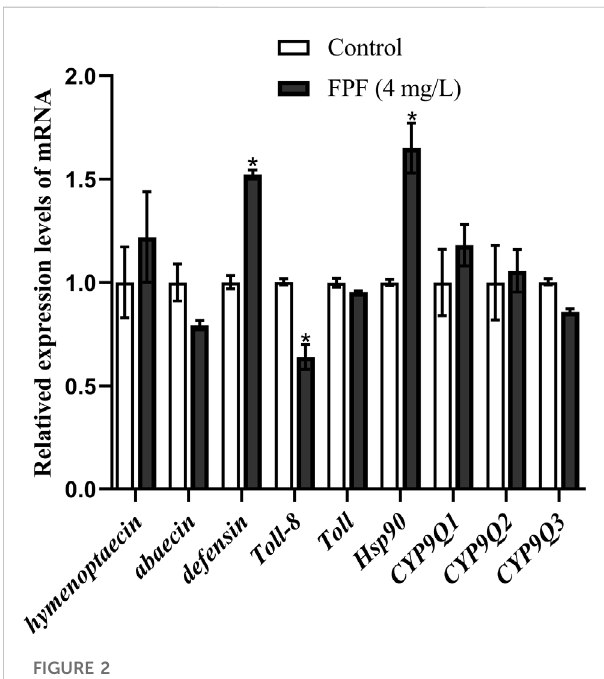
Relative expression levels of